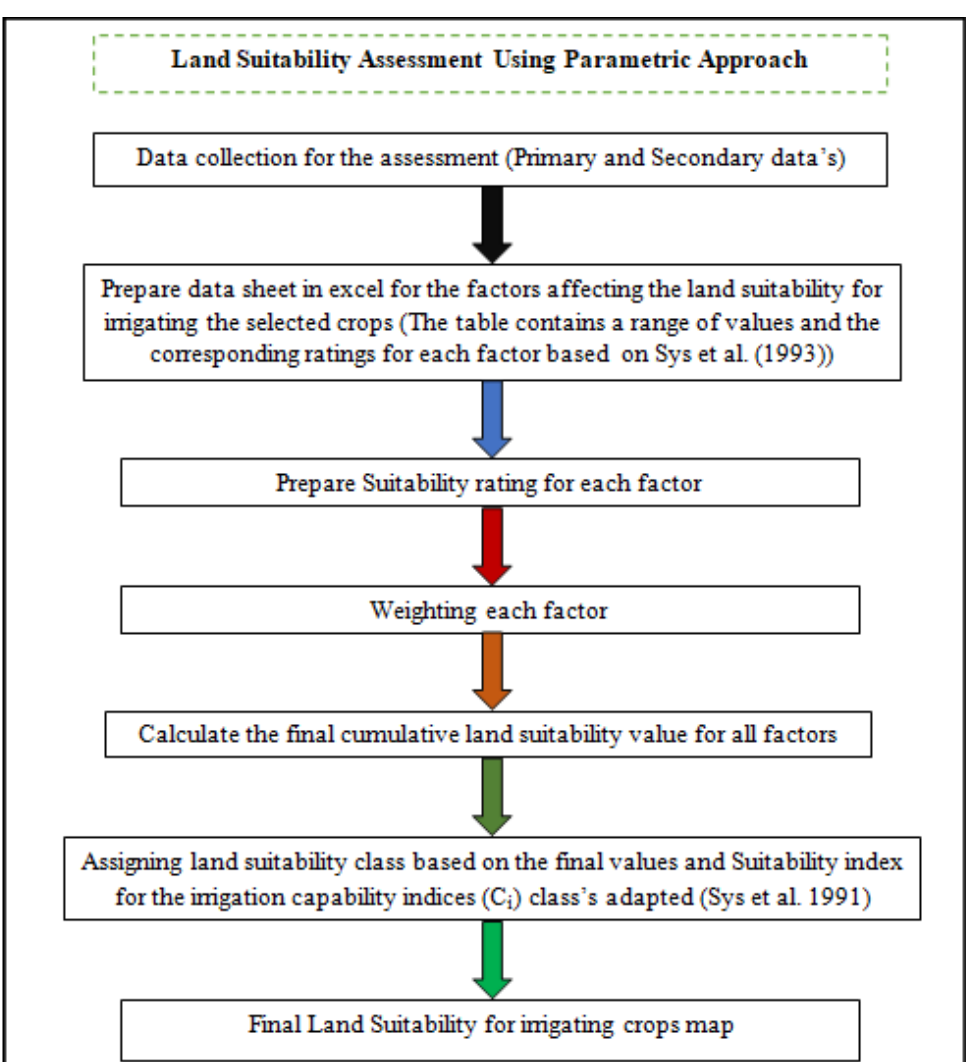
Figure 4. Flow chart of parametric approach for assessing land suitability for irrigating crops. Soil and topographic factors are considered on a numerical scale ranging from 0 to 100%, attributes having certain limitation gets a low rate up, and a high rate is assigned to the most appropriate attribute, which corresponds to a suitability rating based on a parametric evaluation method. The Storie method provides this index as a multiplicative of each characteristic [29], and it is mathematically expressed in (Equation (1)) as follows: B C D E F × × × × Ci = A × 100. (1) 100 100 100 100 where: Ci represents the irrigation suitability index, A represents the soil texture rating, B represents the soil depth rating, C represents the CaCO 3 status rating, D represents the electro conductivity rating, E represents the drainage rating, and F represents the slope rating. The value of the capability index is used to determine suitability categories (Table